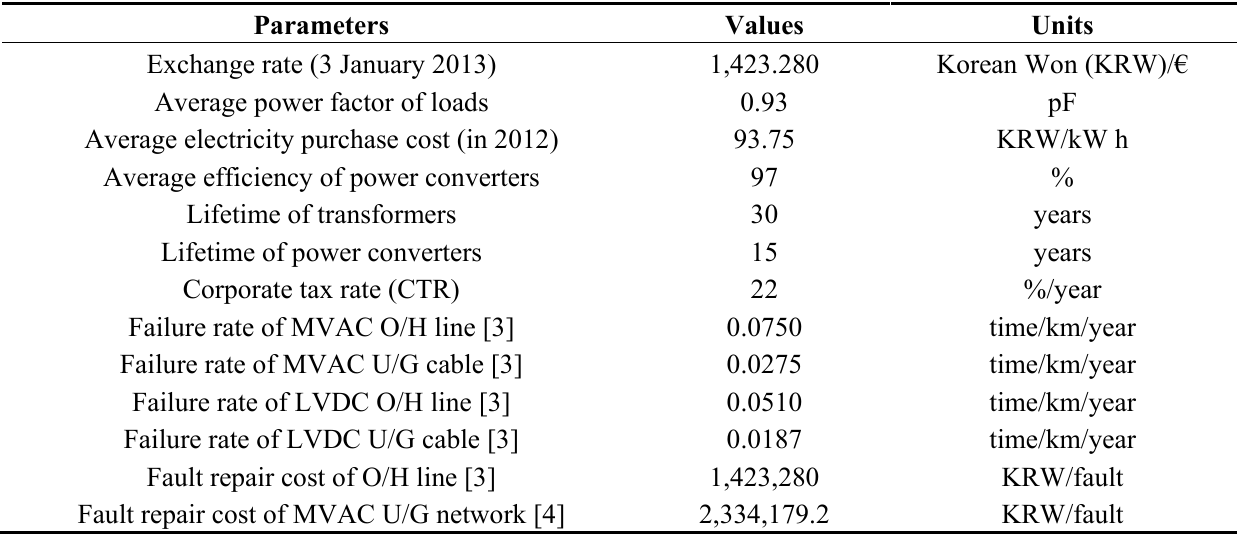
Table 1. Net present value (NPV) analysis parameters. O/H: overhead; U/G: underground; and LVDC: low-voltage direct